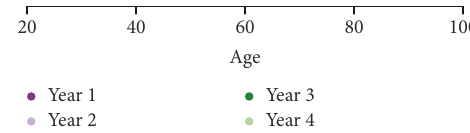
Figure 2: Typical consumption strategies: (1) Youngest first (always uses youngest units at any time until all units are consumed), (2) oldest first (always uses oldest units), and (3) SRS (selects a simple random sample to use in each time